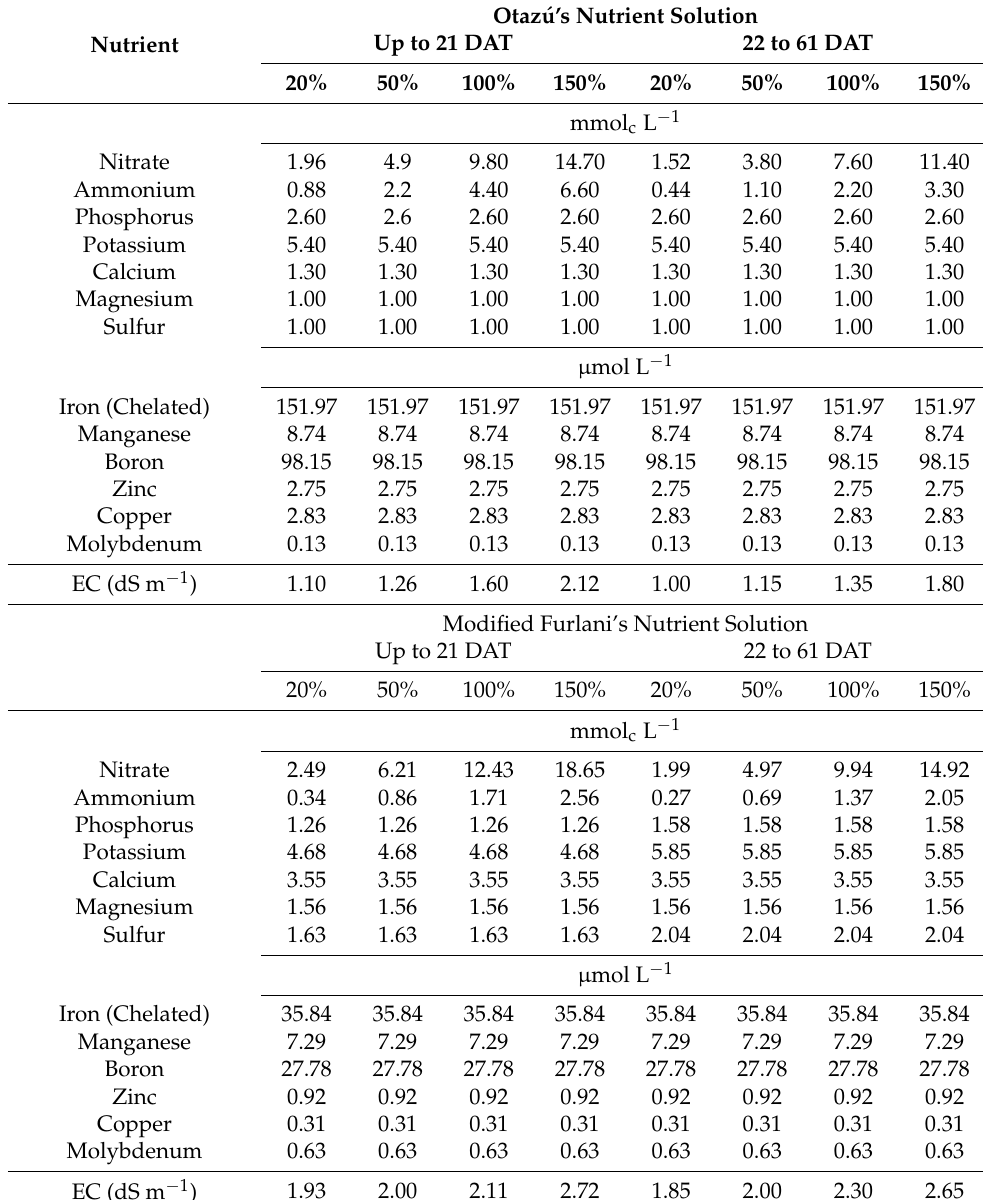
Table 2. Nutrient concentrations in nutrient solutions tested in an aeroponic system to produce nuclear potato